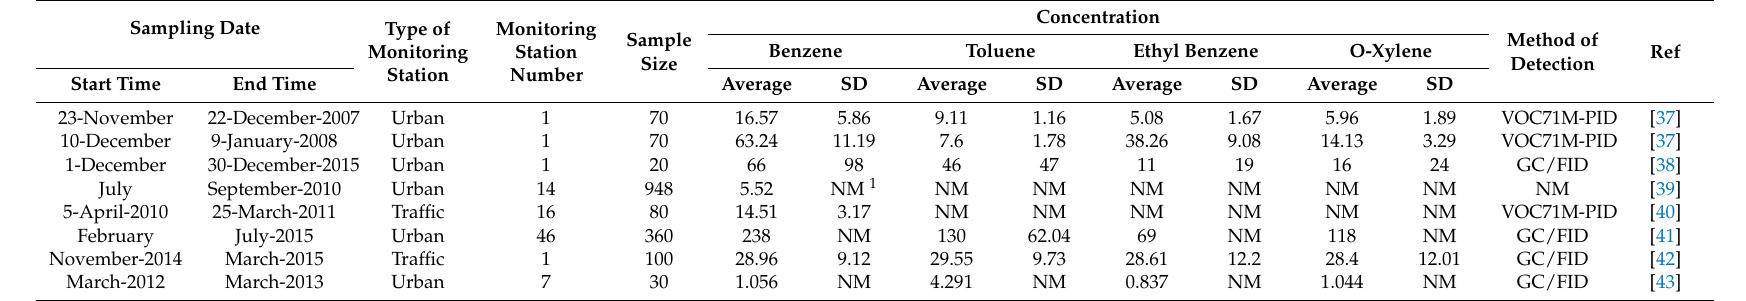
Table 1. Main characteristics included in the